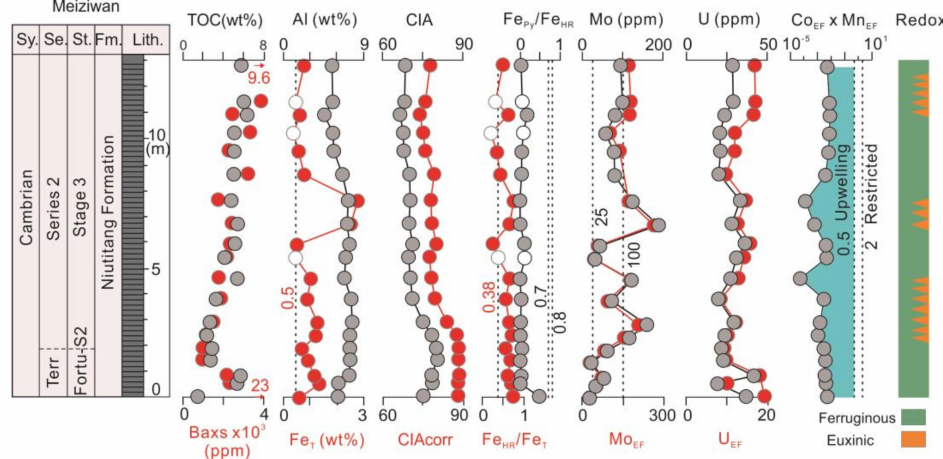
Figure 4. Chemostratigraphic profiles of key geochemical proxies and redox summary for the Meiziwan section. Gray circles correspond to the top axis and red circles correspond to the bottom axis. The vertical dashed lines represent key proxy threshold values (see text for discussion). The unfilled circles in Fe T , Fe HR /Fe T , and Fe py /Fe HR represent samples containing <0.5 wt.% Fe T . Note that two Ba xs outliers at the top and bottom are not shown. Abbreviations: Sy. = System; Se. = Series; St. = Stage; Fm. = Formation; Lith. =